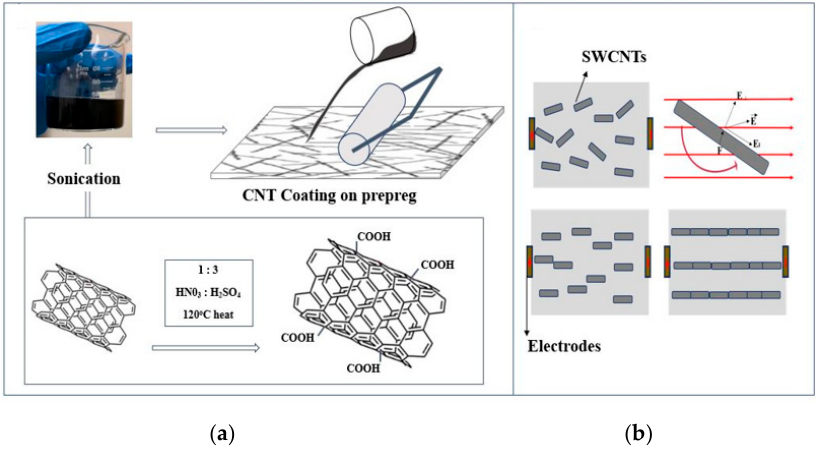
Figure 7. Steps followed in ( a ) the fabrication of SWCNT fiber composite and ( b ) alignment of SWCNTs.